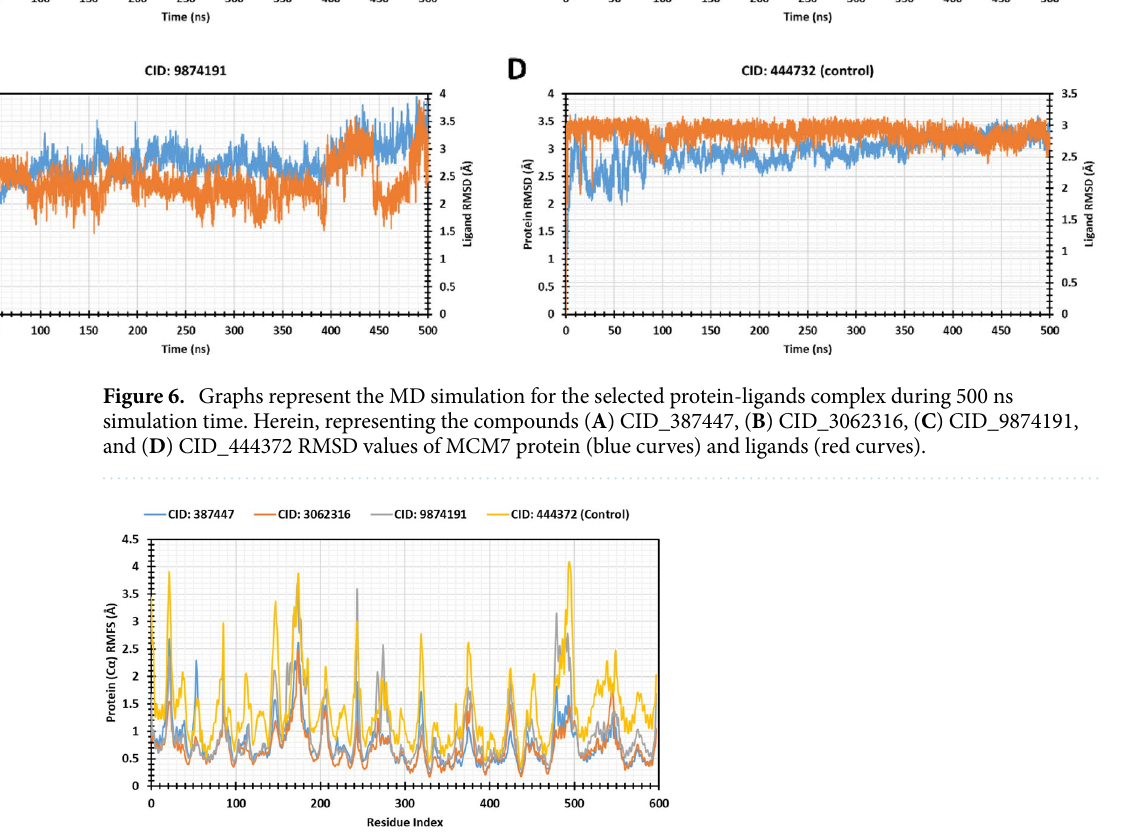
Figure 7. Graphs exhibiting the information about the RMSF values of MCM7 protein by 500 ns time of MD